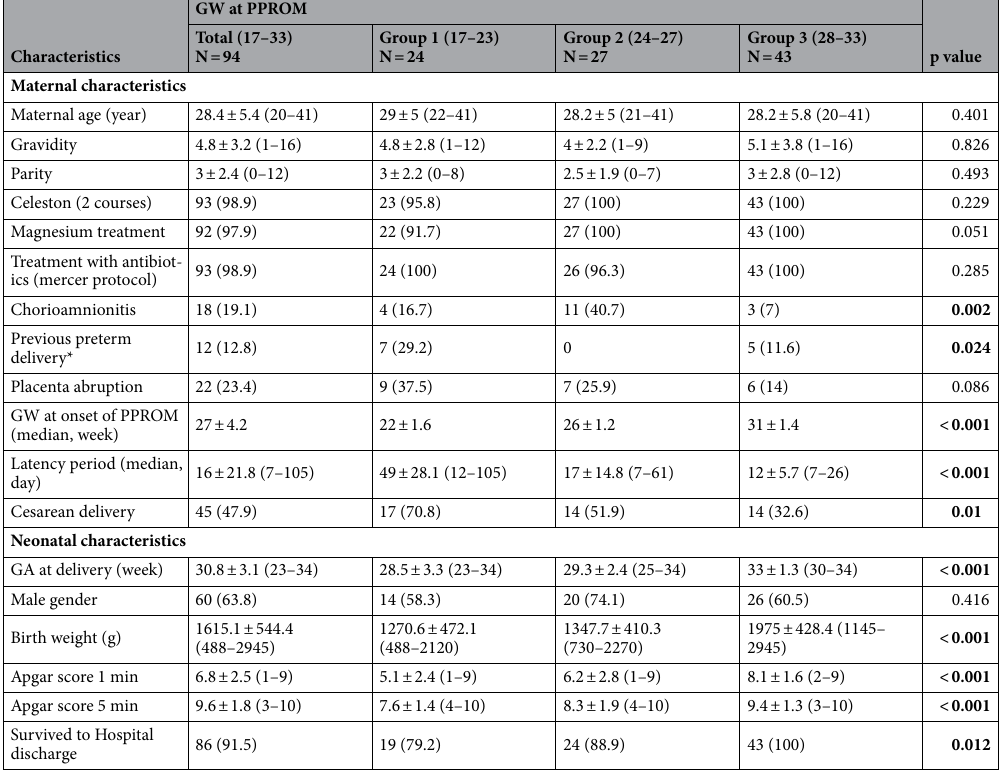
Table 1. Maternal and neonatal characteristics. Data are expressed as mean/median ± standard deviation (range) or n (%). GA gestational age, GW gestational week. *2 missing values. Significant values are in bold.